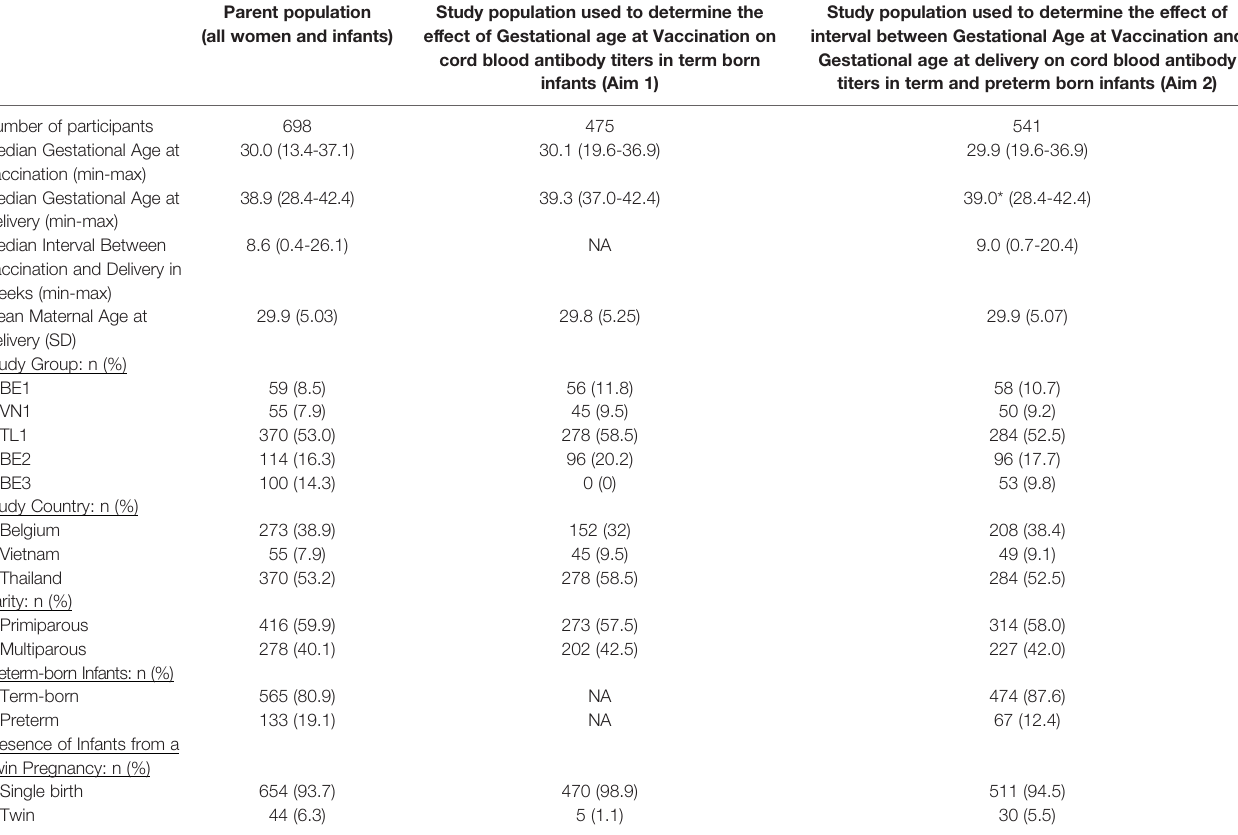
TABLE 2 | General characteristics of parent population and study population by aim. Parent population Study population used to determine the (all women and infants) effect of Gestational age at Vaccination on cord blood antibody titers in term born infants (Aim